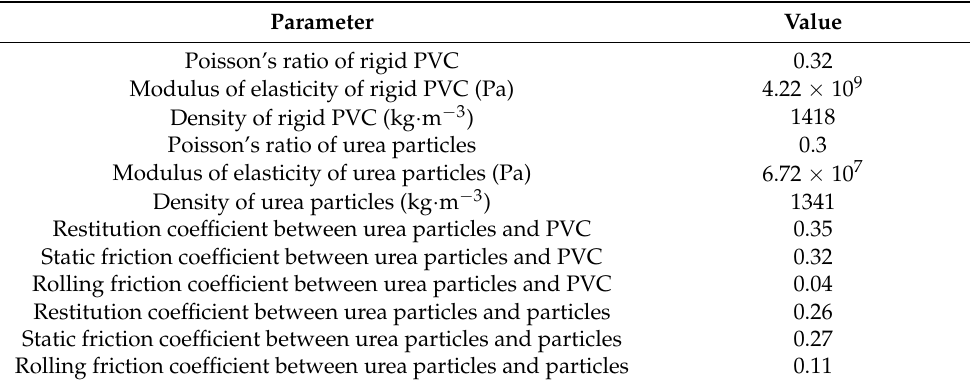
Table 5. Material parameters required for